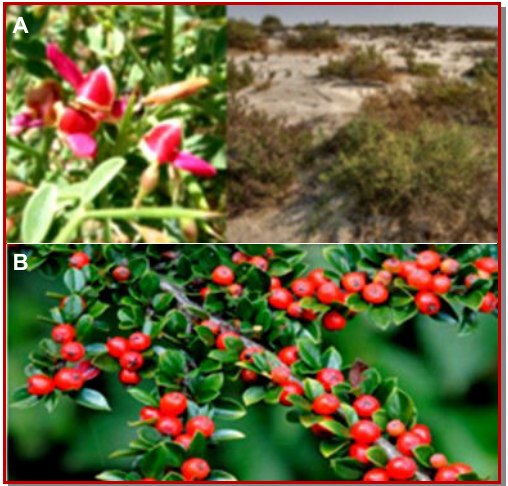
A Figure 1: Alhagi camelorum (A), and Cotoneaster discolor (B) as the sources of manna